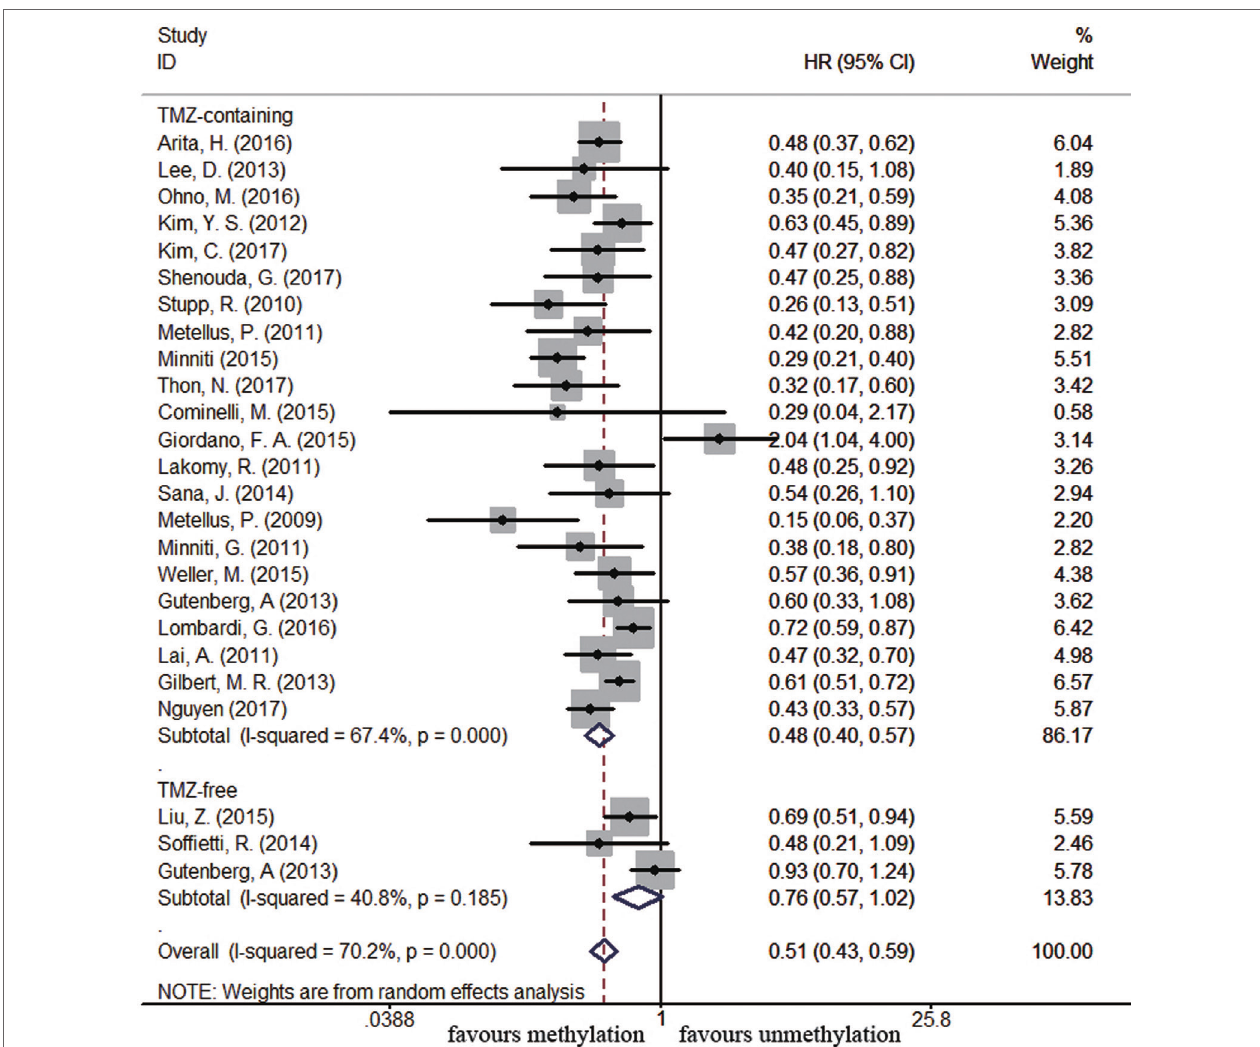
FiGURe 3 | Calculated hazard ratios (HRs) and 95% confidence intervals (CIs) for the relationship between methylation and progression-free survival benefit from temozolomide (TMZ)-containing or TMZ-free therapy in overall glioblastoma patients (methylated vs. unmethylated